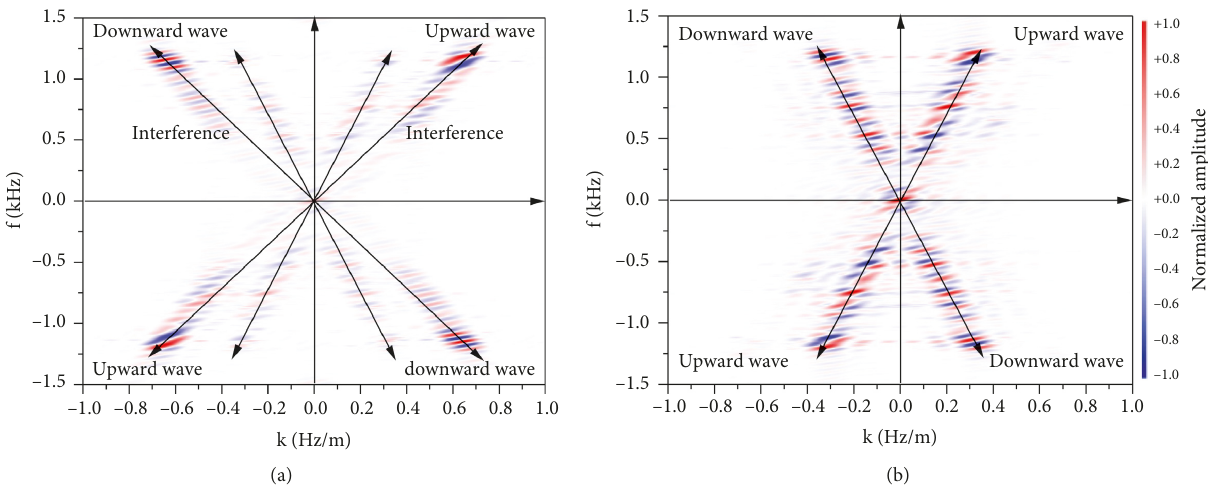
Figure 19: Results of the frequency-wavenumber domain analysis of the numerical data ( x data at B i .